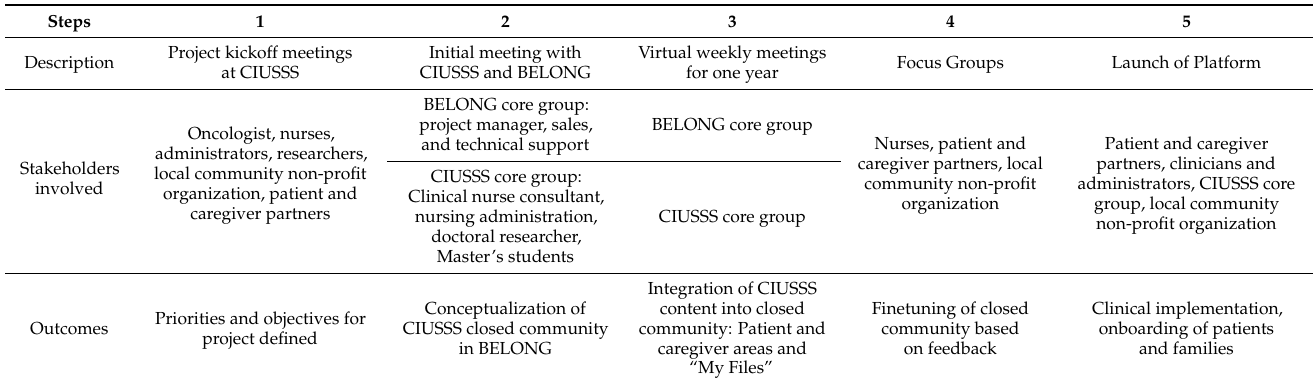
Table 1. Overview of implementation process—steps, stakeholders, and outcomes.